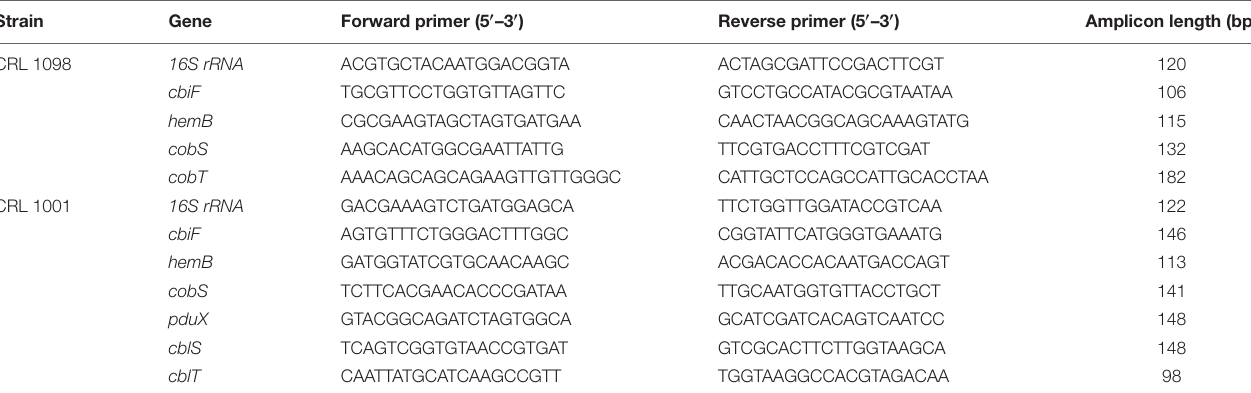
TABLE 1 | Primer sequences of key genes of de novo biosynthesis of cobalamin-type corrinoid compounds.